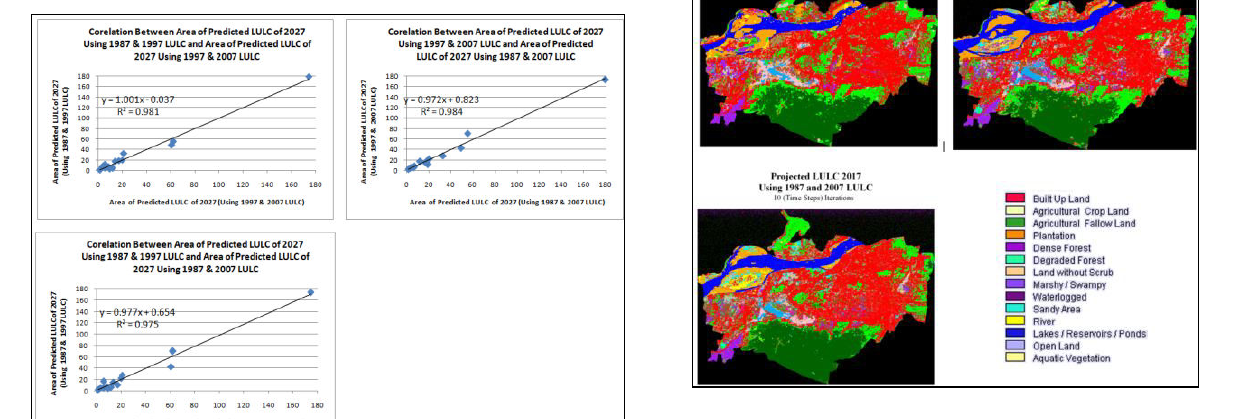
Figure 7. Predicted LULC of 2017 using 1987 & 1997 LULC image, using 1997 & 2007 LULC image and using 1987 & 2007 LULC image Figure 5. Relationships between area statistics of predicted LULC of 2027 using 1987 & 1997 LULC image, area statistics of predicted LULC of 2027 using 1997 & 2007 LULC image and area statistics of predicted LULC of 2027 using 1987 & 2007 LULC image